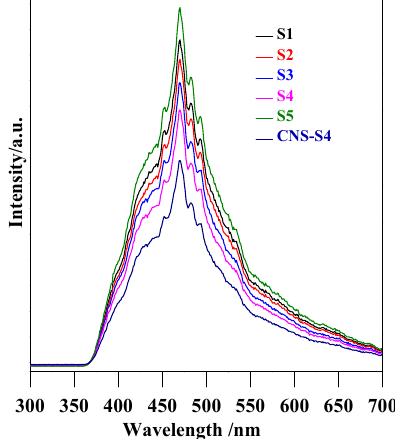
Figure 11. PL spectra of S1, S2, S3, S4, and CNS-S4 samples.